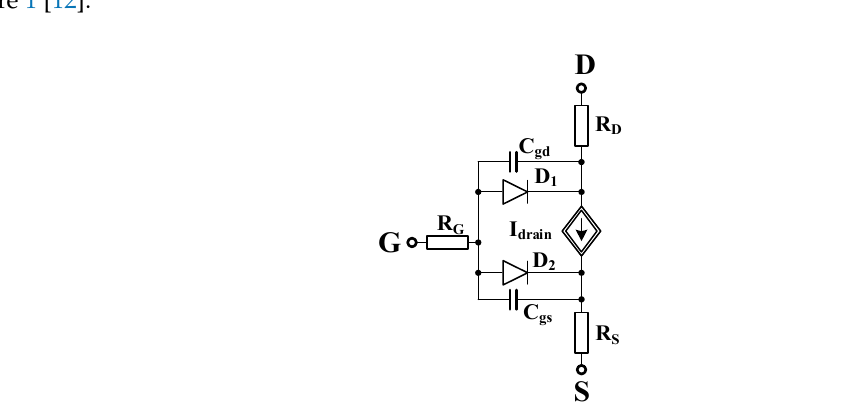
Figure 1. Network form of the Shichman–Hodges (S–H) model of the junction field-effect transistor (JFET) in Simulation Program with Integrated Circuit Emphasis (SPICE).